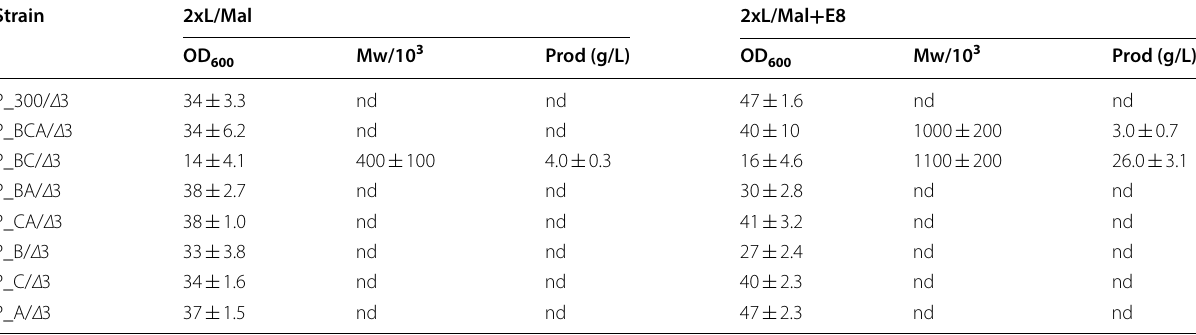
Data are presented as means of five independent experiments